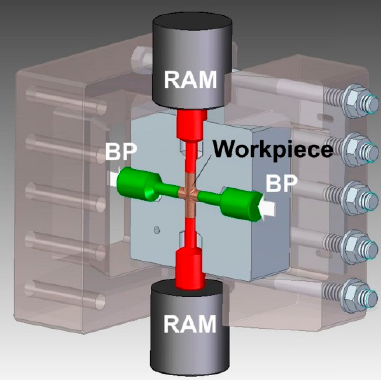
Figure 2. The die for cross-channel extrusion with back pressure (BP).